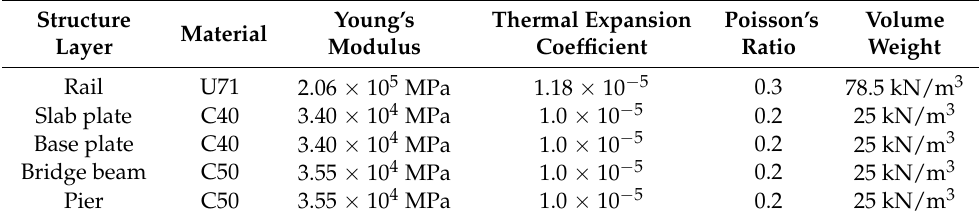
Table 1. Main properties of the track and the bridge.